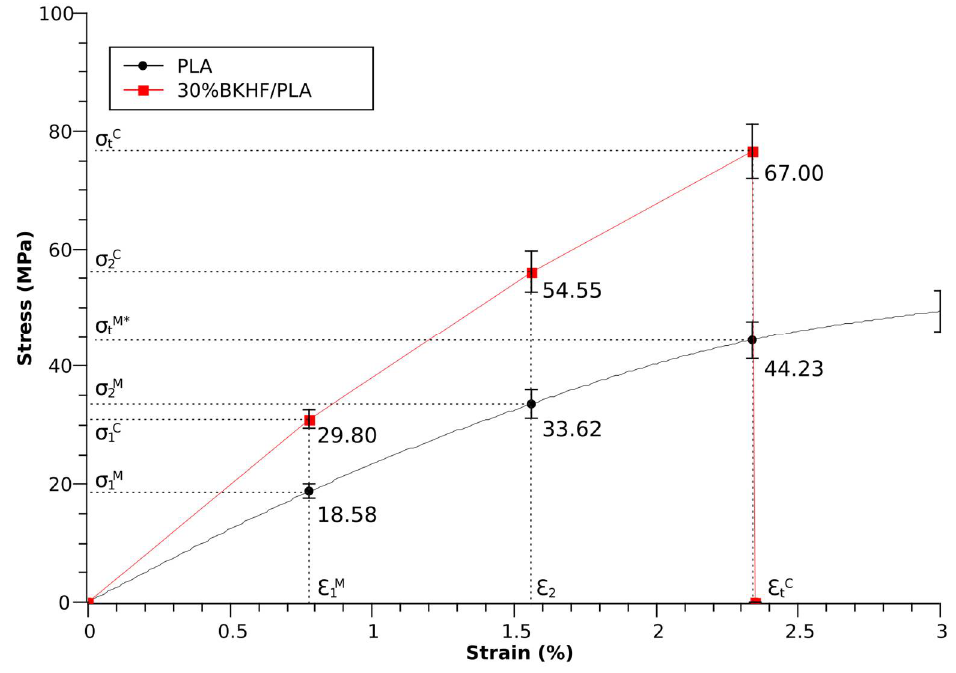
Figure 3. Stress-strain curves of the PLA matrix and the composite reinforced with a 30% bleached kraft hardwood fibers (BKHF). The intermediate strain points used to solve the Kelly and Tyson modified equation are indicated with the subscripts 1 and 2, respectively.